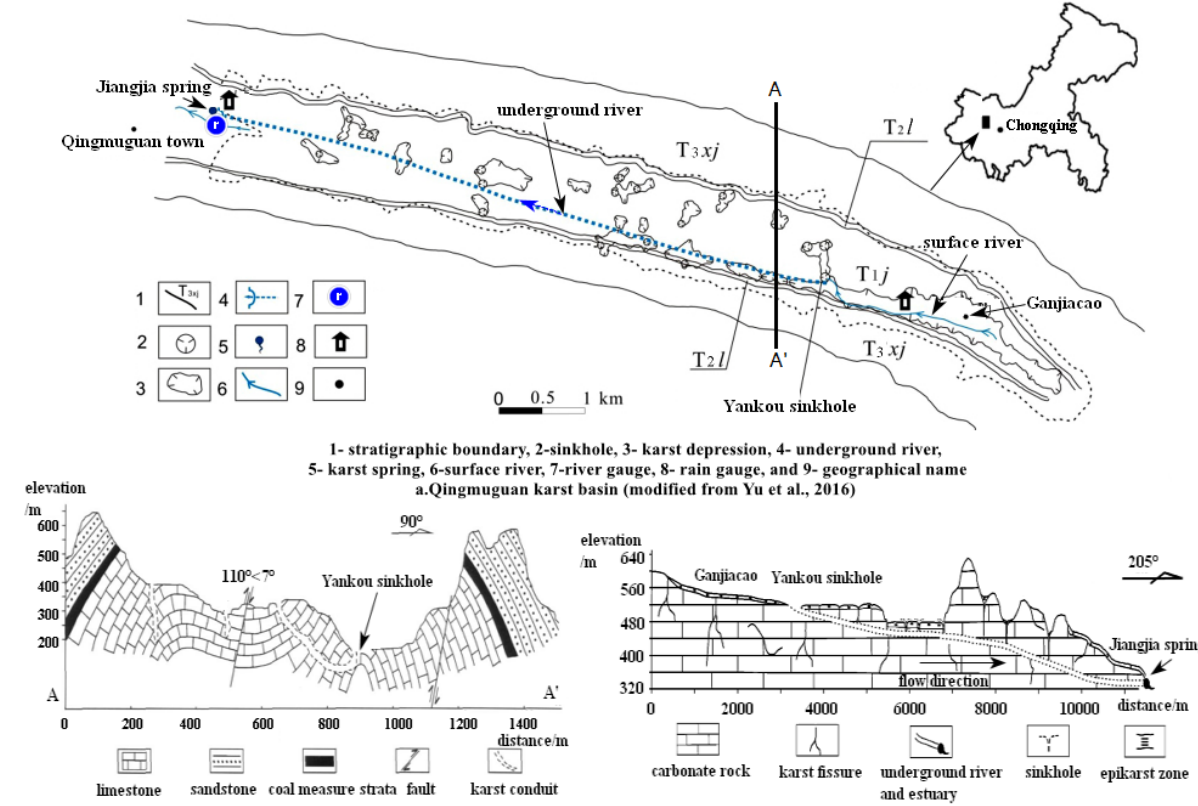
Figure 1. The Qingmuguan karst